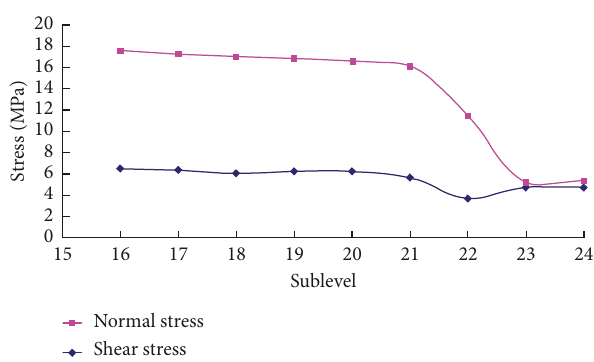
Figure 19: Relationship of stress state of fault FC3 with mining